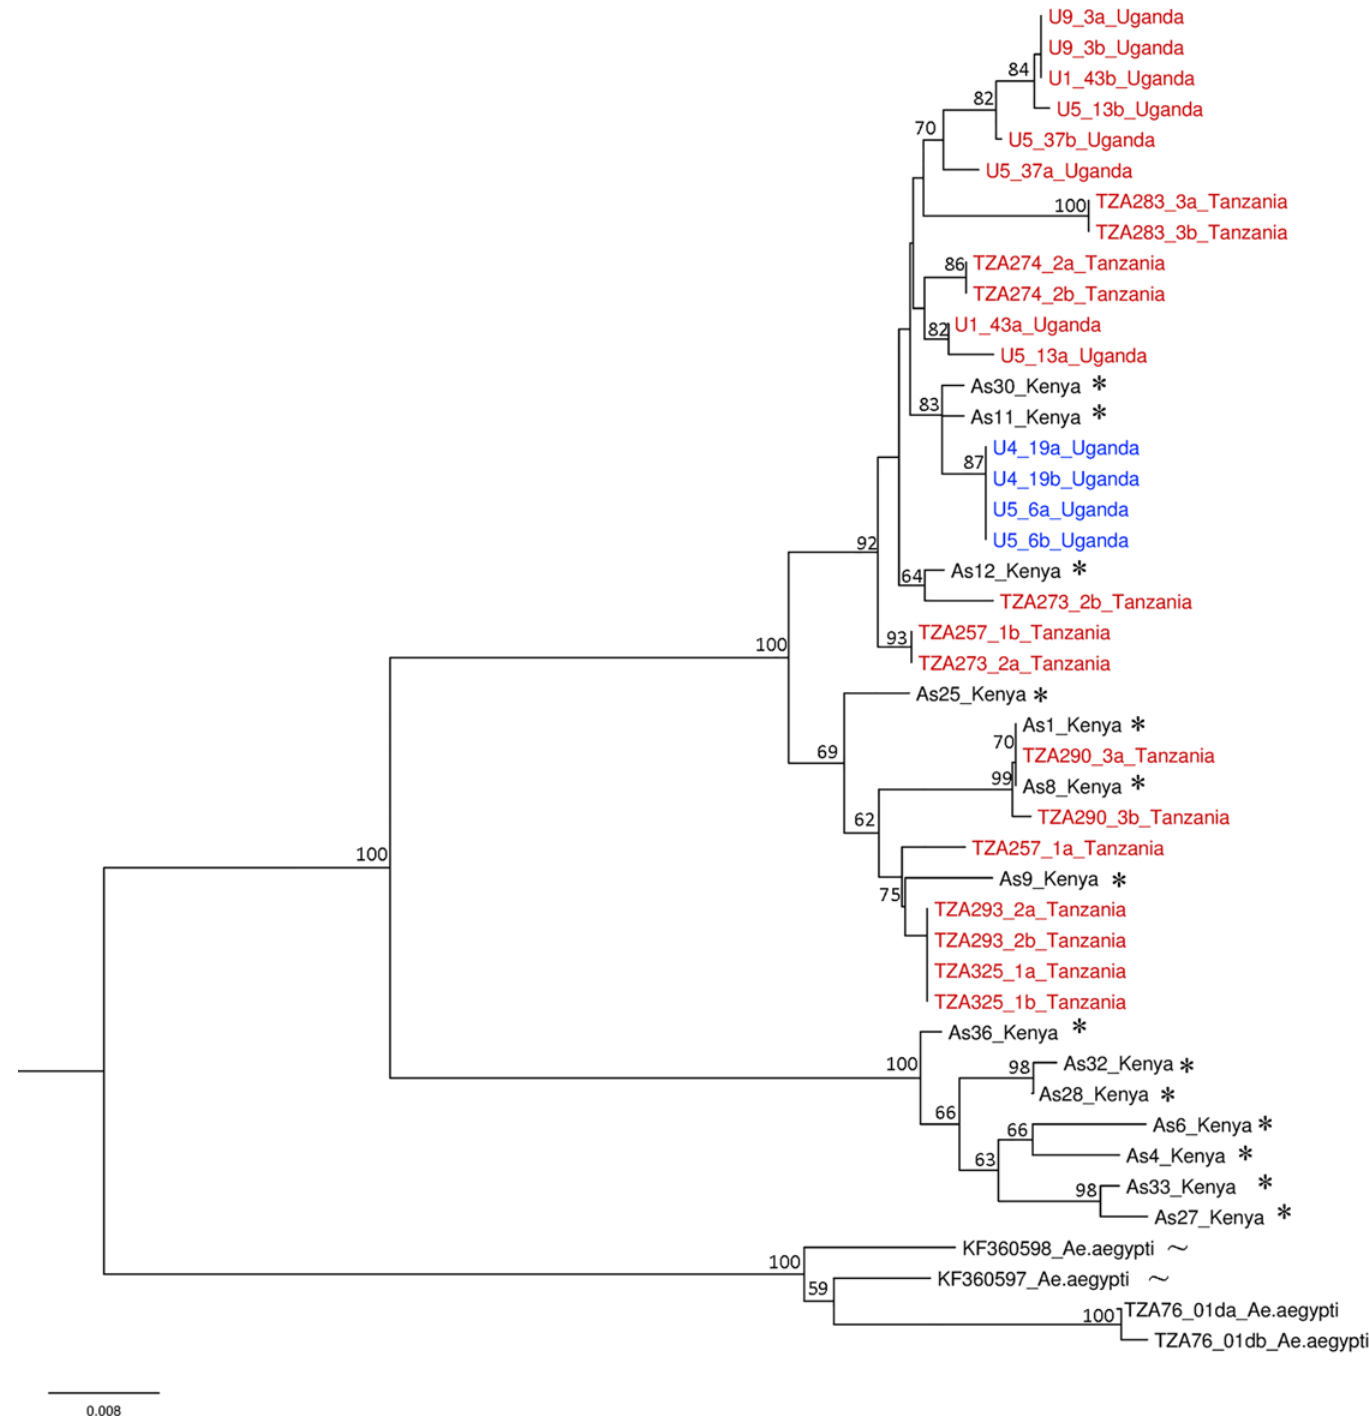
Fig 3. Neighbour joining tree of apoLp2 sequence data with labels coloured according to ITS -based species designation. Red labels represent Ae . bromeliae while blue labels are Ae . lilii . Sequences from Walter et al . [28] ( * ) and Ae . aegypti outgroups (~) from Brown et al . [47] are annotated. Bootstrap support values for branches above 55% are